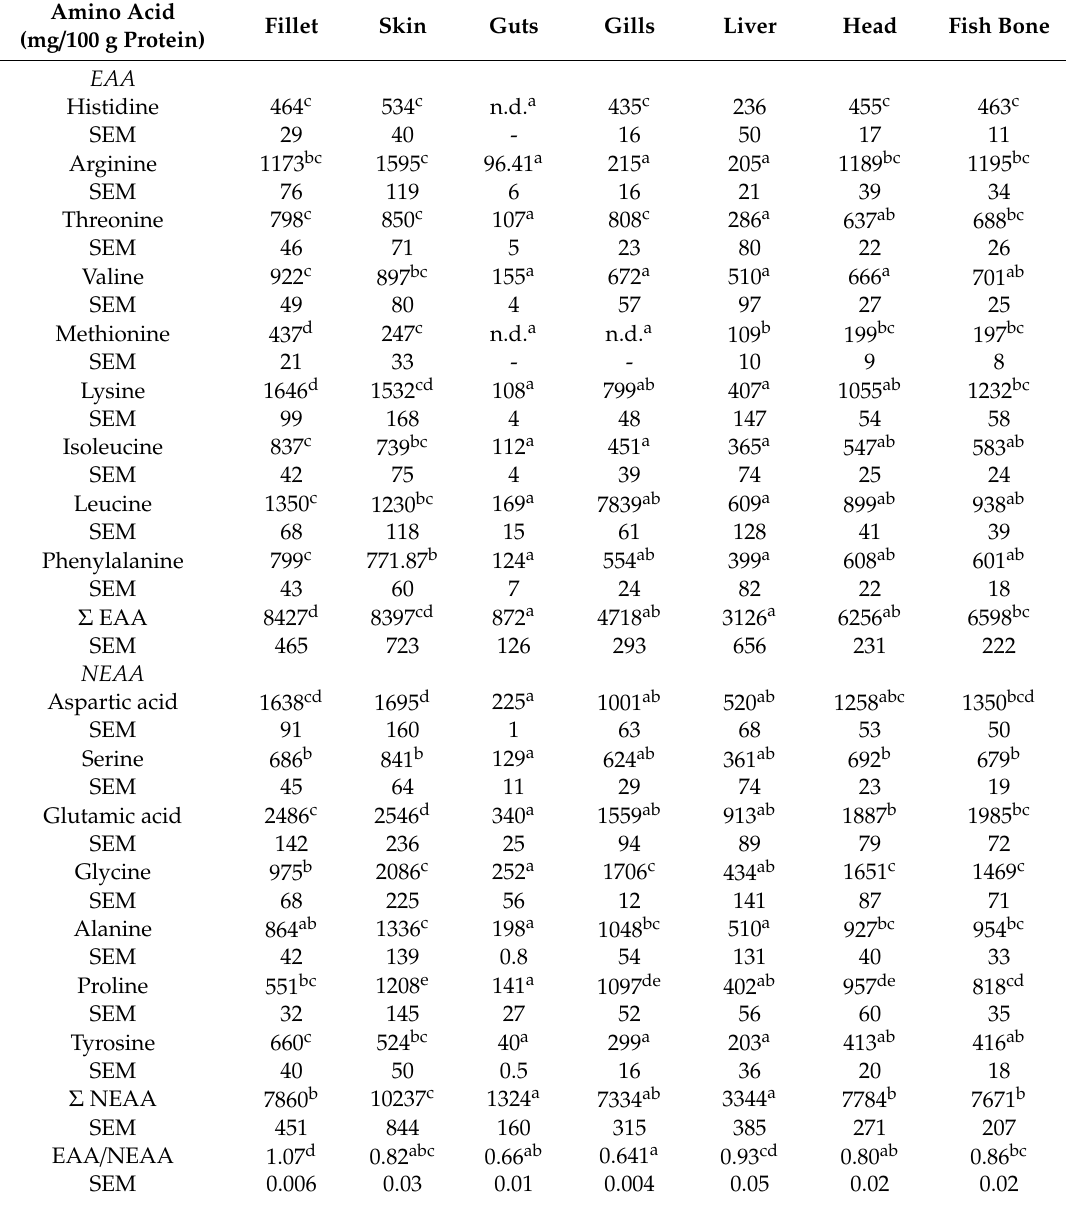
Table 2. Amino-acid profile of sea bass fillet and